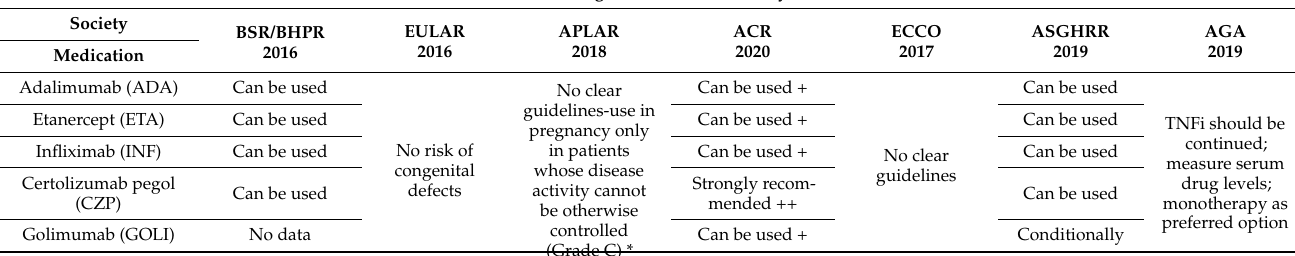
Table 2. TNF-alpha inhibitors management in patients with inflammatory diseases prior to conception based on the recommendations/guidelines of: (i) Rheumatological Medical Societies: British (BSR—The British Society for Rheumatology and BHPR (British Health Professionals in Rheumatology) [78]; European (EULAR—European League Against Rheumatism) [130]; Asia Pacific Region–(APLAR—Asia Pacific League of Associations for Rheumatology) [131]; American (ACR — American College of Rheumatology) [77]; (ii) Gastroenterological Medical Societies: Austrian (ASGHRR—Austrian Societies of Gastroenterology and Hepatology and Rheumatology and Rehabilitation) [133], European (ECCO—European Crohn’s and Colitis Organisation) [132], American (AGA—American Gastroenterological Association) [134]. Medical Societies Recommendations for Management of Inflammatory Diseases PRIOR TO